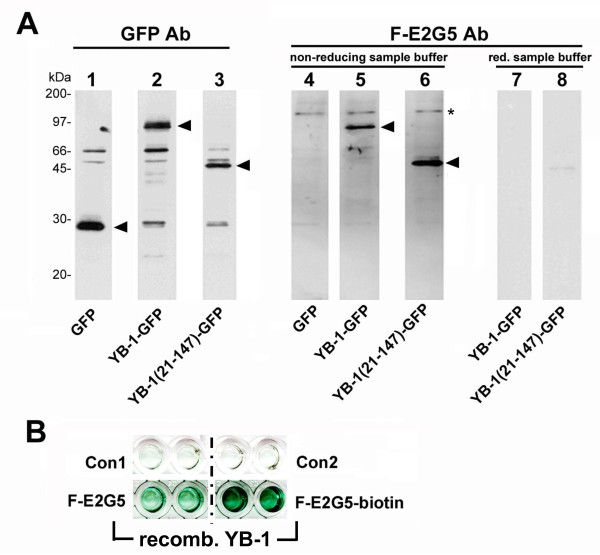
Detection of YB-1-GFP and YB-1(21-147)-GFP by immunoblot and recombinant YB-1 by ELISA. (A) HEK293T cell extracts containing GFP (lanes 1 and 4), YB-1-GFP (lane 2, 5 and 7) or YB-1(21-147)-GFP proteins (lanes 3, 6 and 8) were separated in denaturing gels and following transfer to nitrocellulose probed with GFP antibody (lanes 1 to 3) or Mab F-E2G5 (lanes 4 to 8). Relative mobilities of expressed proteins are indicated by arrowheads. Notably, reducing sample buffer prevents detection of tagged YB-1 proteins by immunoblot (lanes 7 and 8). (B) ELISA was performed by coating with recombinant affinity purified hexahistidin-tagged YB-1 protein. Biotin-labeled Mab F-E2G5 yields an even stronger signal than non-biotinylated Mab. Controls included omission of antibody (Con1) or antigen (Con2).